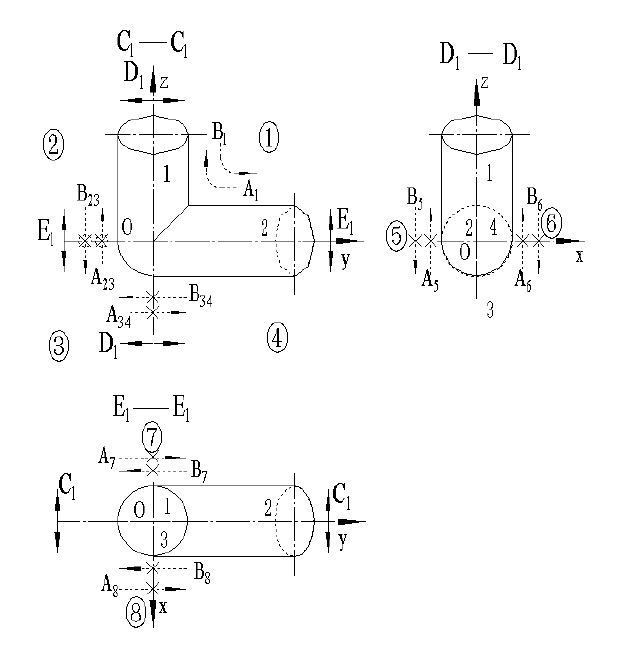
Fig. 13 Motion planning for the L